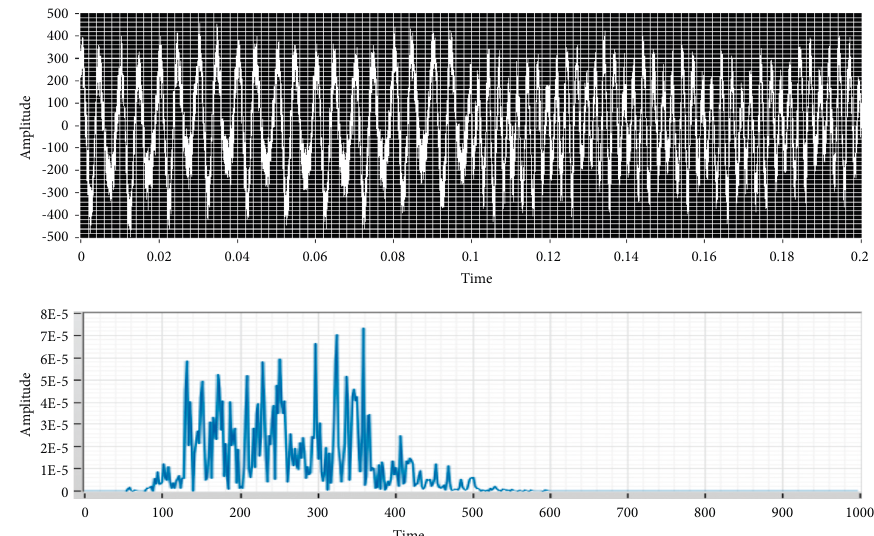
Figure 5: Time-domain and frequency-domain diagrams of bearing fault vibration signal at 1200r/min